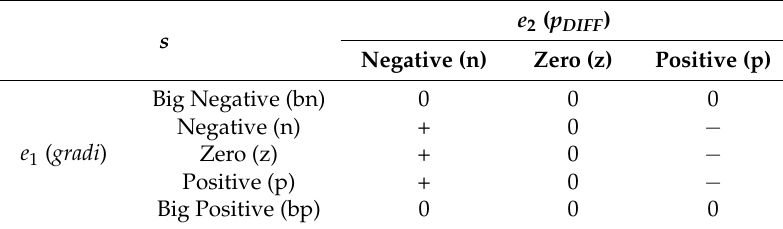
Table 4. Fuzzy rule